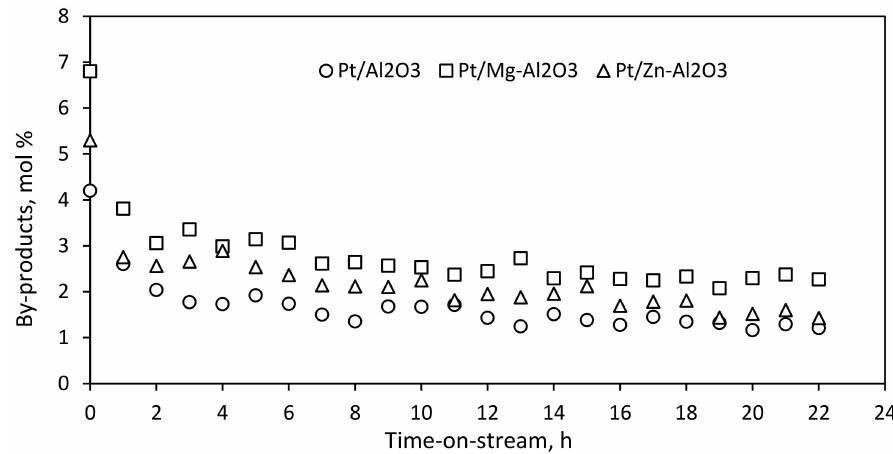
Figure 5. Amounts of by-products obtained over 22 h of catalyst time-on-stream. Reaction parameters: Pt loading 0.5 wt.%, H18-DBT doh 99.6%, reaction temperature 300 ◦ C, feed flow 1.3 mL/min, catalyst mass 110 g, weight hourly space velocity 0.61 h − 1 .